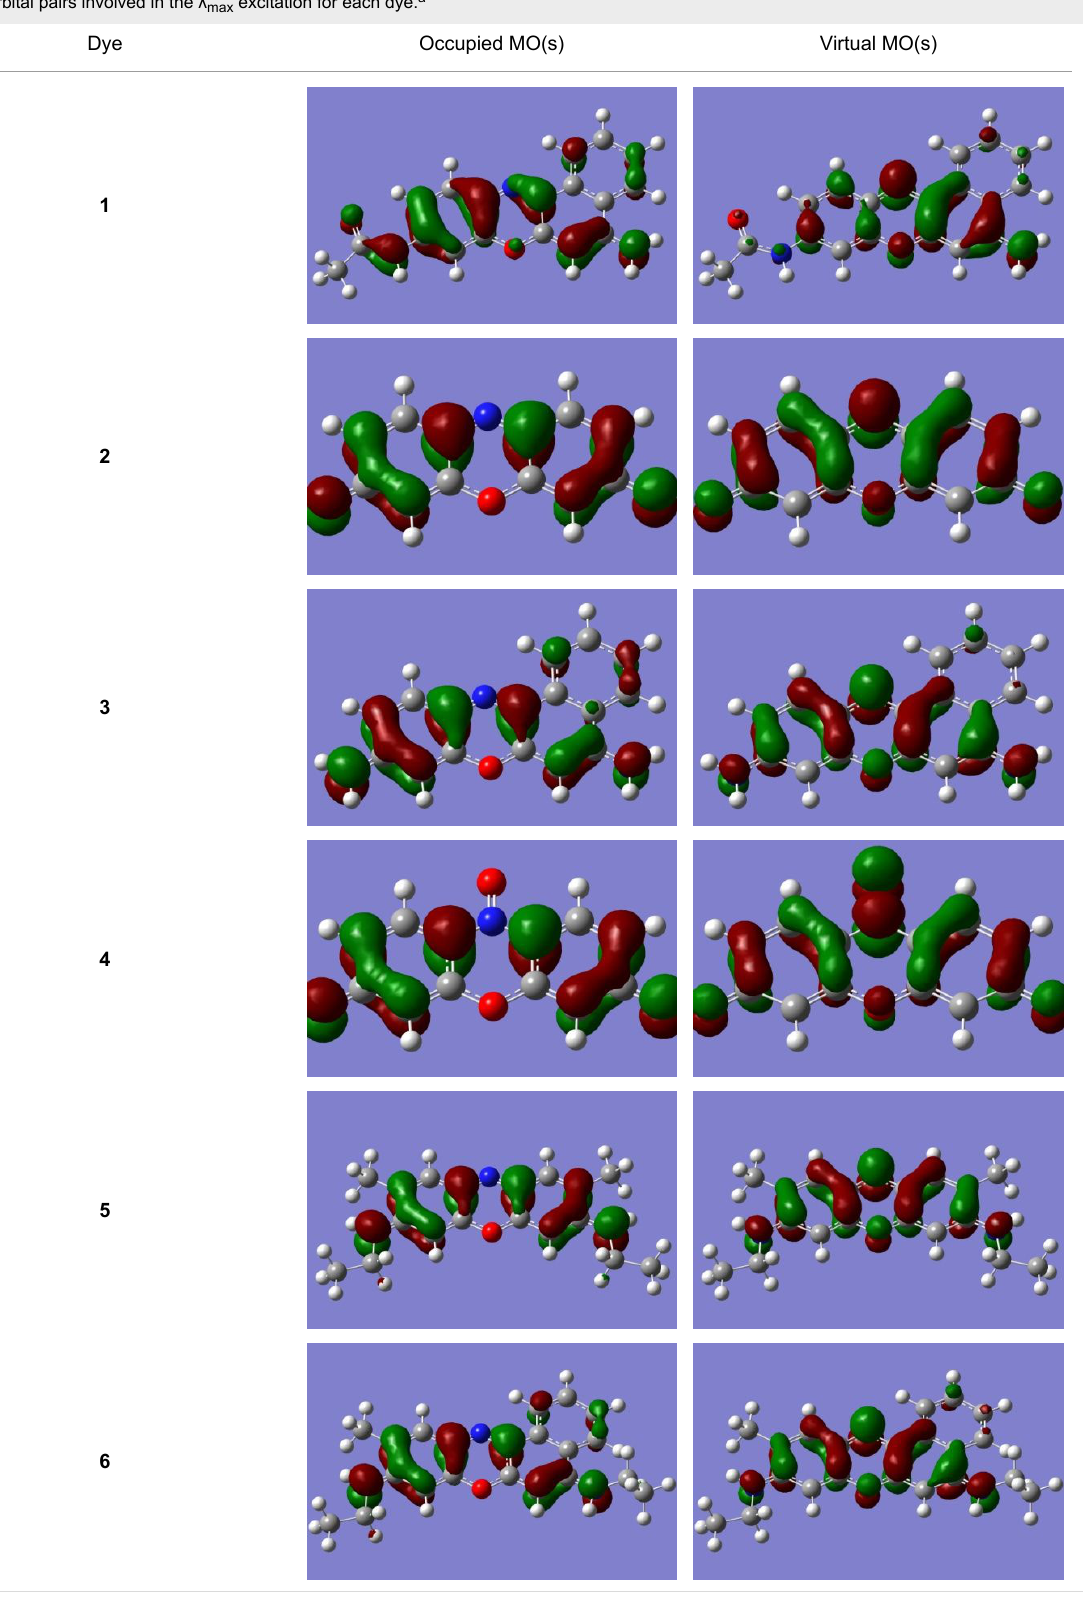
Table 4: Orbital pairs involved in the λ max excitation for each dye.